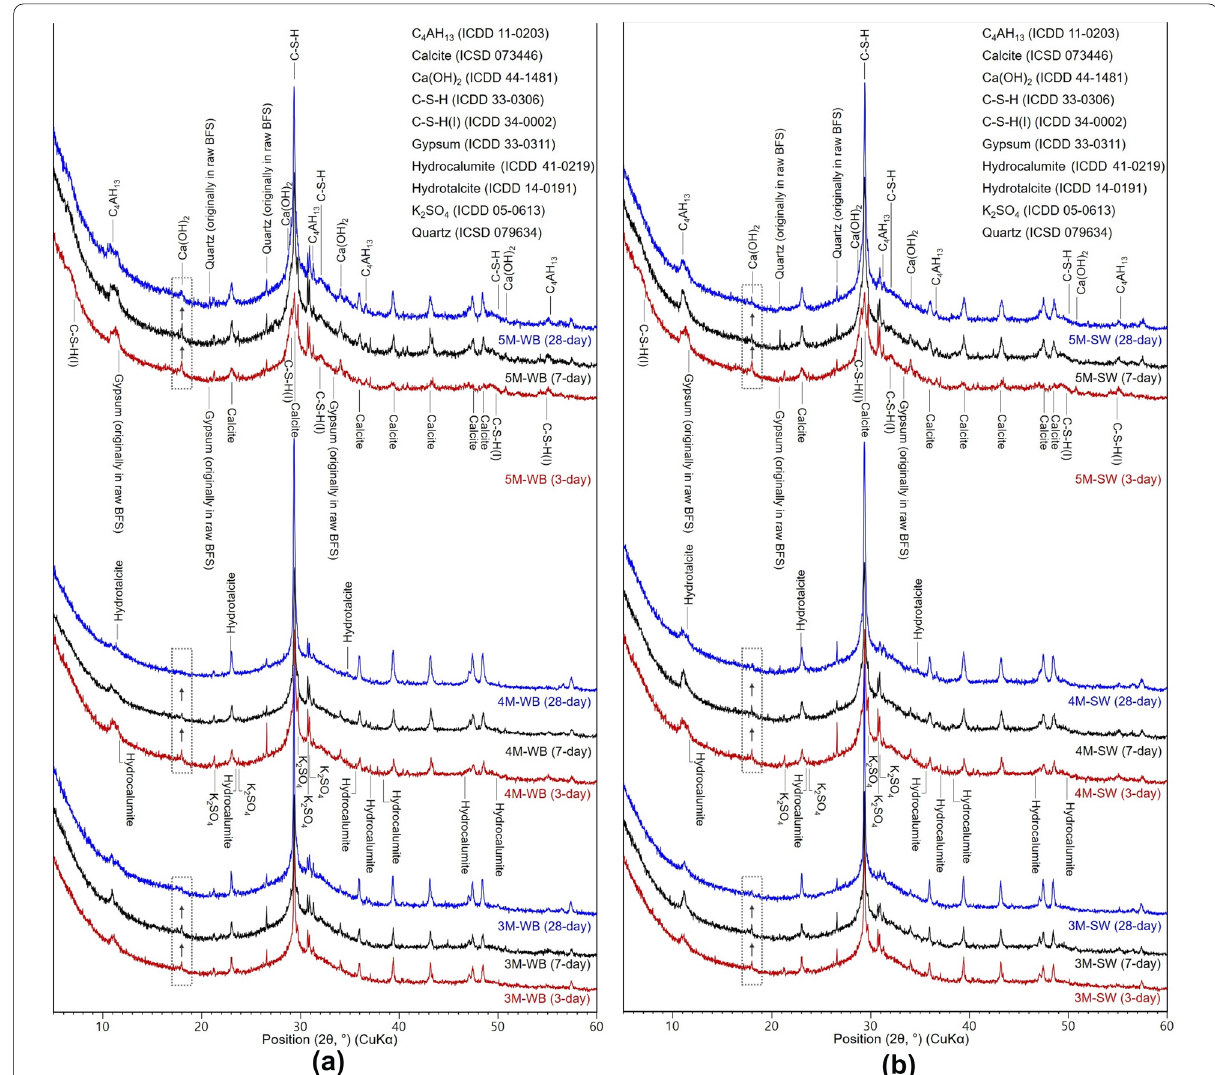
Fig. 3 XRD patterns of CO 2 -cured alkali-activated BFS (with different activator concentrations) subjected to ( a ) further water bath curing and ( b ) seawater